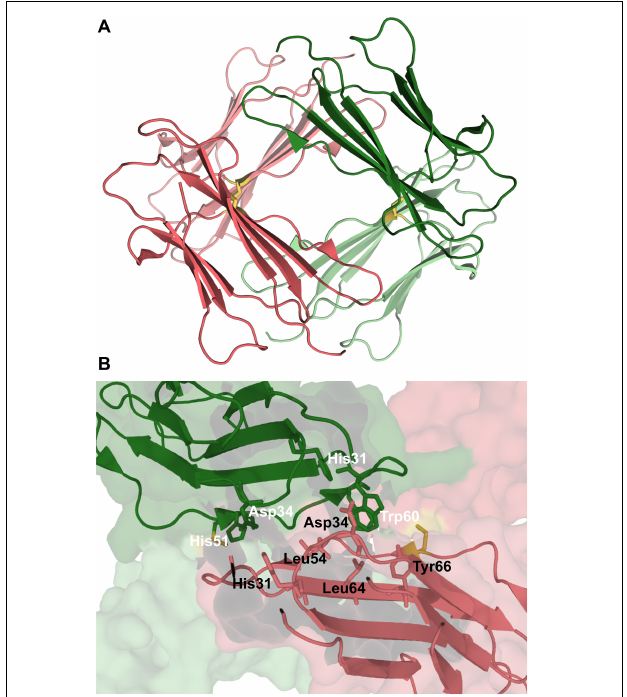
FIGURE 6 | Tetramer of β 2m. Three-dimensional structure of the tetramer (A) , formed by two disulfide linked homodimers at Cys50 (PDB ID: 3TM6). In this representation the homodimers are colored green and pink, respectively. The DD strand interfacial region in (B) is the largest found in this tetramer being stabilized by hydrogen bonds between His31 and Asp34, and hydrophobic interactions involving Trp60, Leu54, Leu64, and Tyr66.